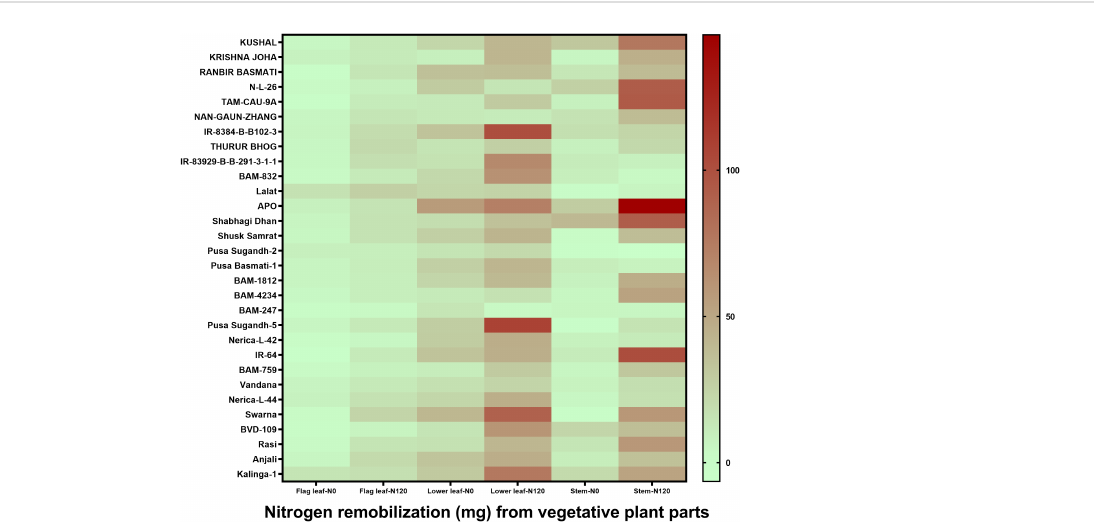
FIGURE 5 Effect of nitrogen de fi cient (0 kg ha-1 fertilizer N: N0) and nitrogen suf fi cient (120 kg ha-1 fertilizer N: N120) fi eld conditions on nitrogen remobilization from vegetative plant parts ( fl ag leaf, lower leaf, and stem) to grain in fi eld- grown diverse rice genotypes during the 2019-kharif season. Values presented are Mean±SE with three